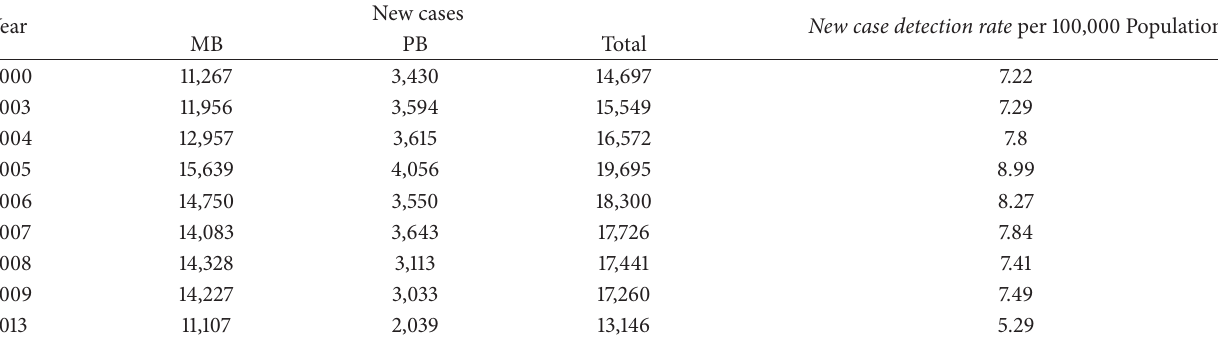
Table 1: Leprosy new cases in Indonesia 2000–2013